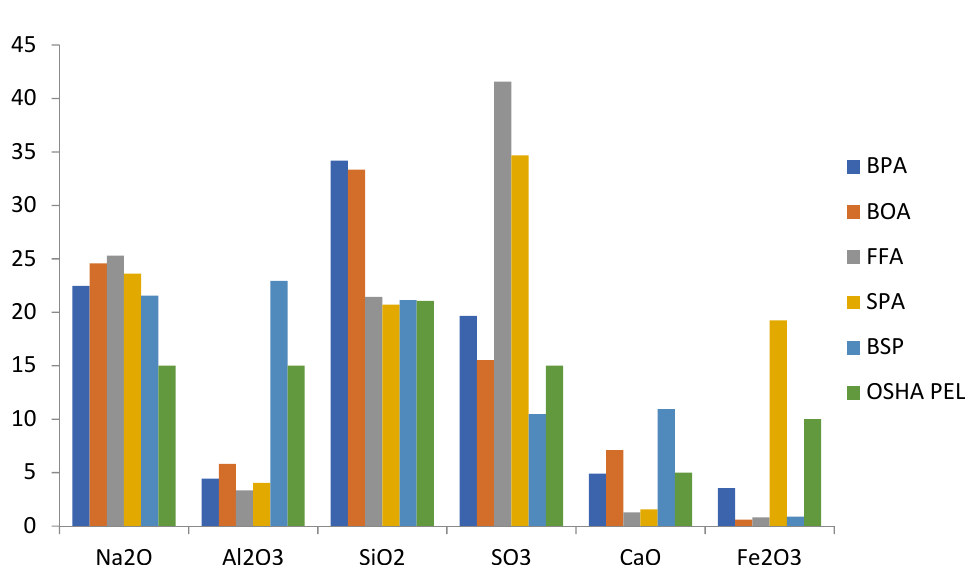
Figure 6. Concentrations (mg/m 3 ) of Characterized Particulate Matter vs. OSHA PELs.